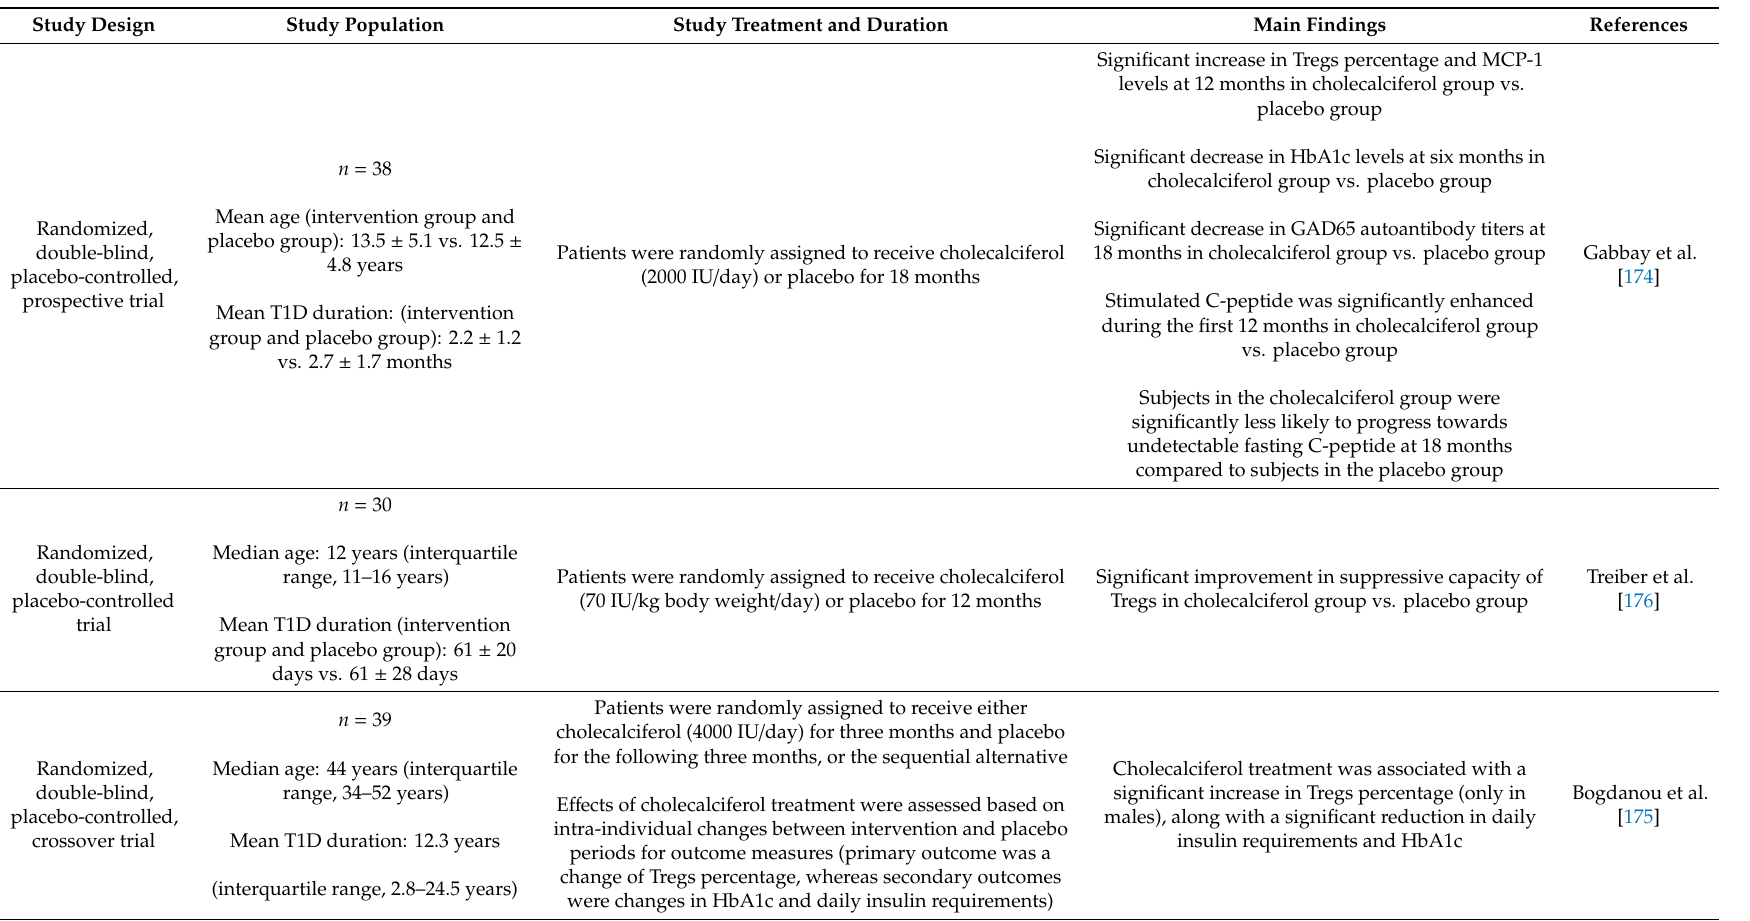
Table 1. Summary of the main studies on the use of vitamin D in addition to insulin therapy in patients with new-onset and established T1D. Abbreviations: 25(OH)D, 25-hydroxivitamin D; CRP, C-reactive protein; DHA, docosahexaenoic acid; GAD65, glutamic acid decarboxylase; HbA1c, glycated hemoglobin; IL-6, interleukin 6; LADA, latent autoimmune diabetes in adults; MCP-1, monocyte chemoattractant protein 1; n / a, not available; T1D, type 1 diabetes; TNF- α , tumor necrosis factor-alpha; Tregs, regulatory T cells; UCB, umbilical cord